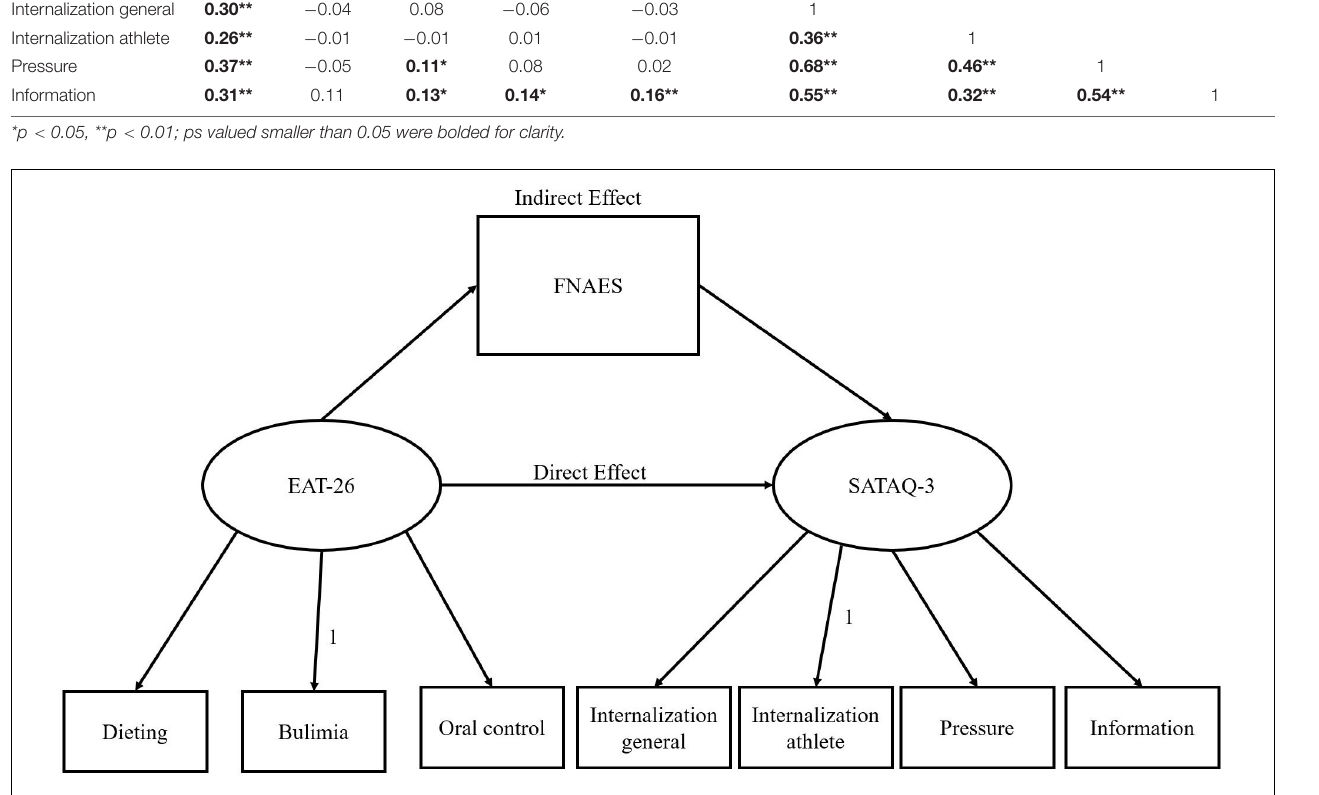
FIGURE 1 | Path analysis of the relationship between FNAES, EAT-26, and SATAQ-3 scores of the participants. TABLE 3 | Bootstrap analysis of the mediation effect size and significance test of FNAES in EAT-26 and